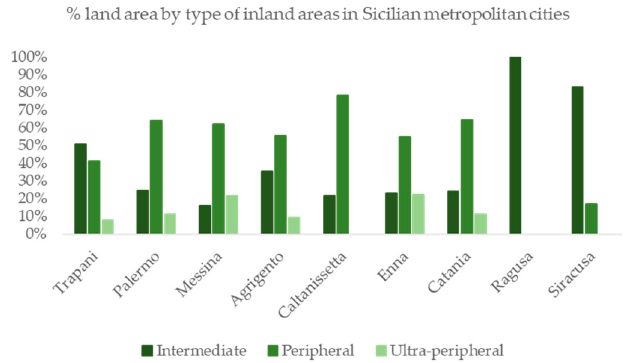
Figure 6. Percentage of land area by type of inland areas in Sicilian metropolitan cities. (Authors’ elaboration from NSIA data.)